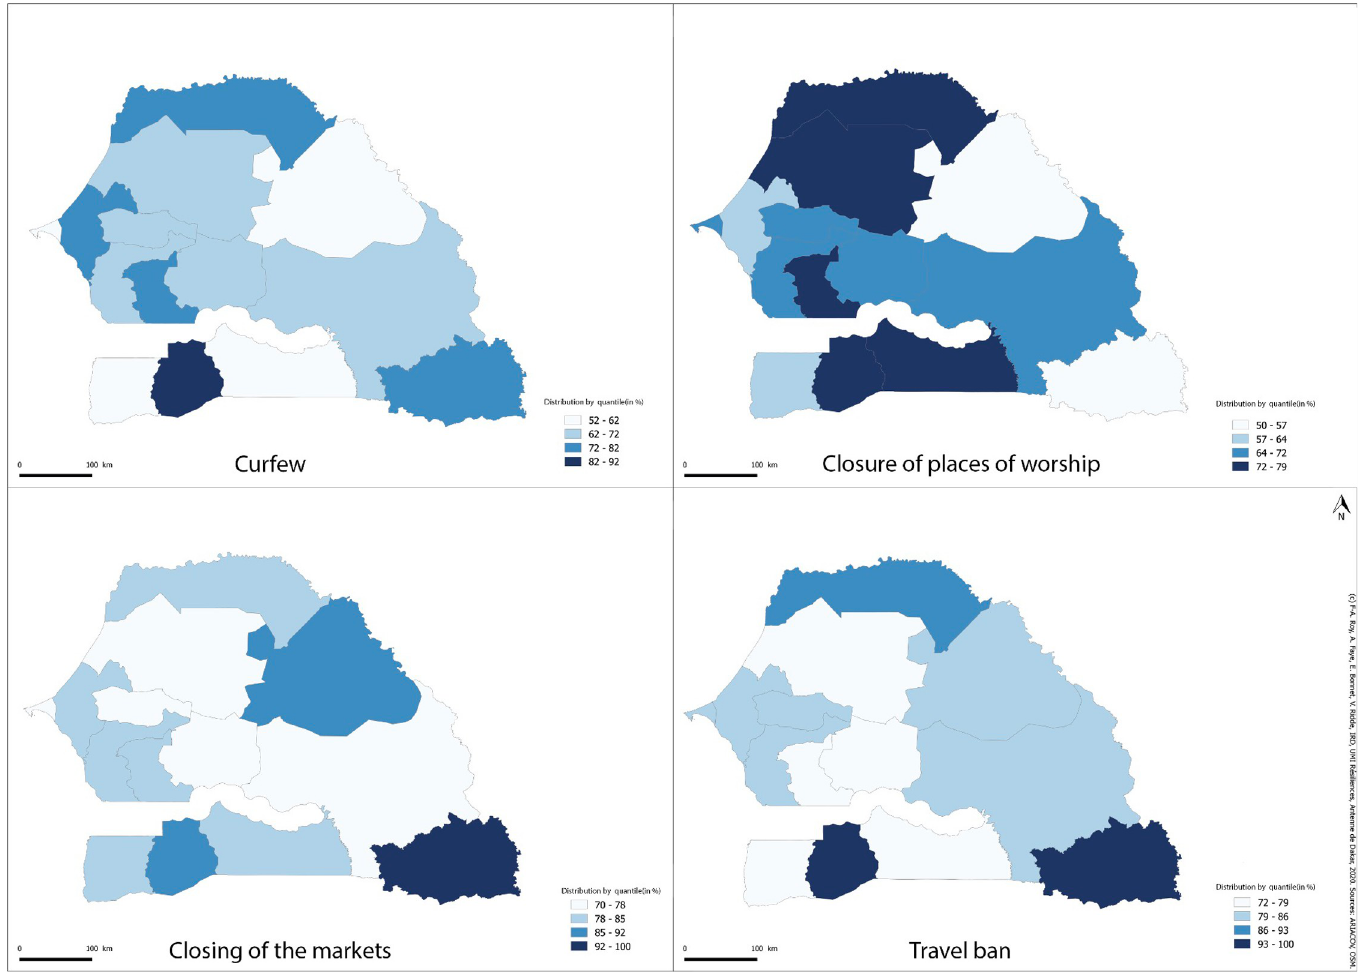
Fig 5. Regional distribution of perceived effectiveness of the four